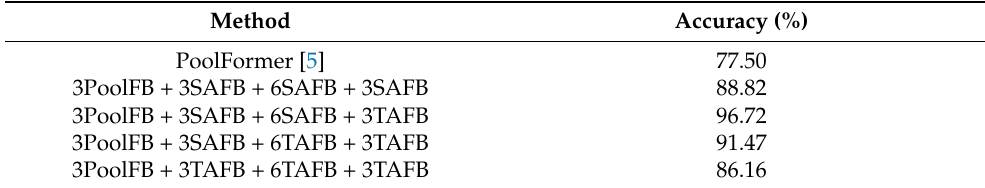
Table 4. Ablation results of the proposed method.